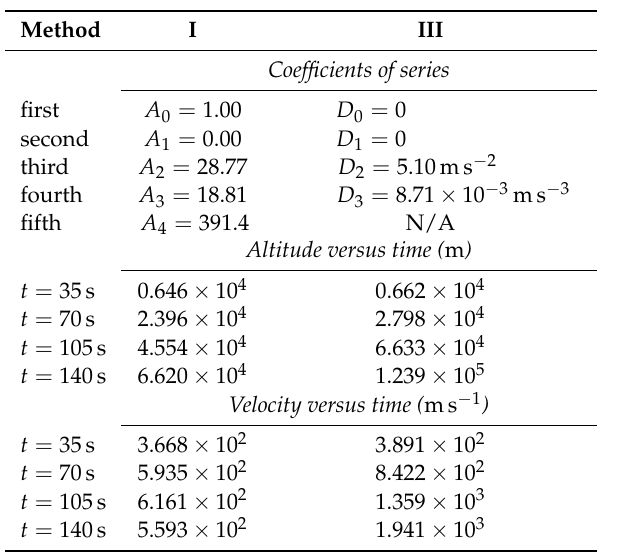
Table 3. Calculation of powered trajectories with four discretizations for method I in Section 6.1 and method III in Section